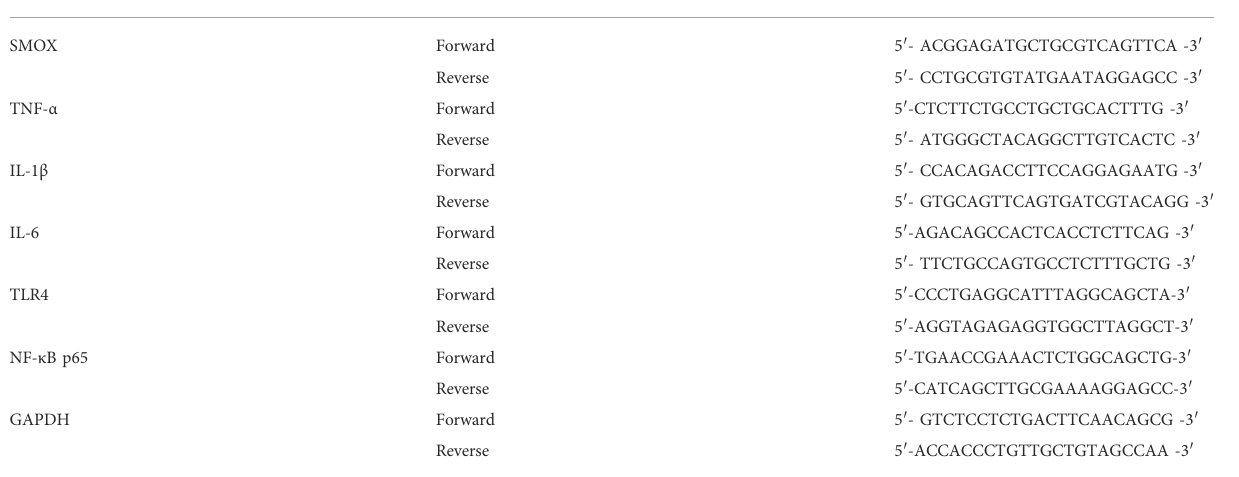
TABLE 1 List of primers designed for qRT-PCR.